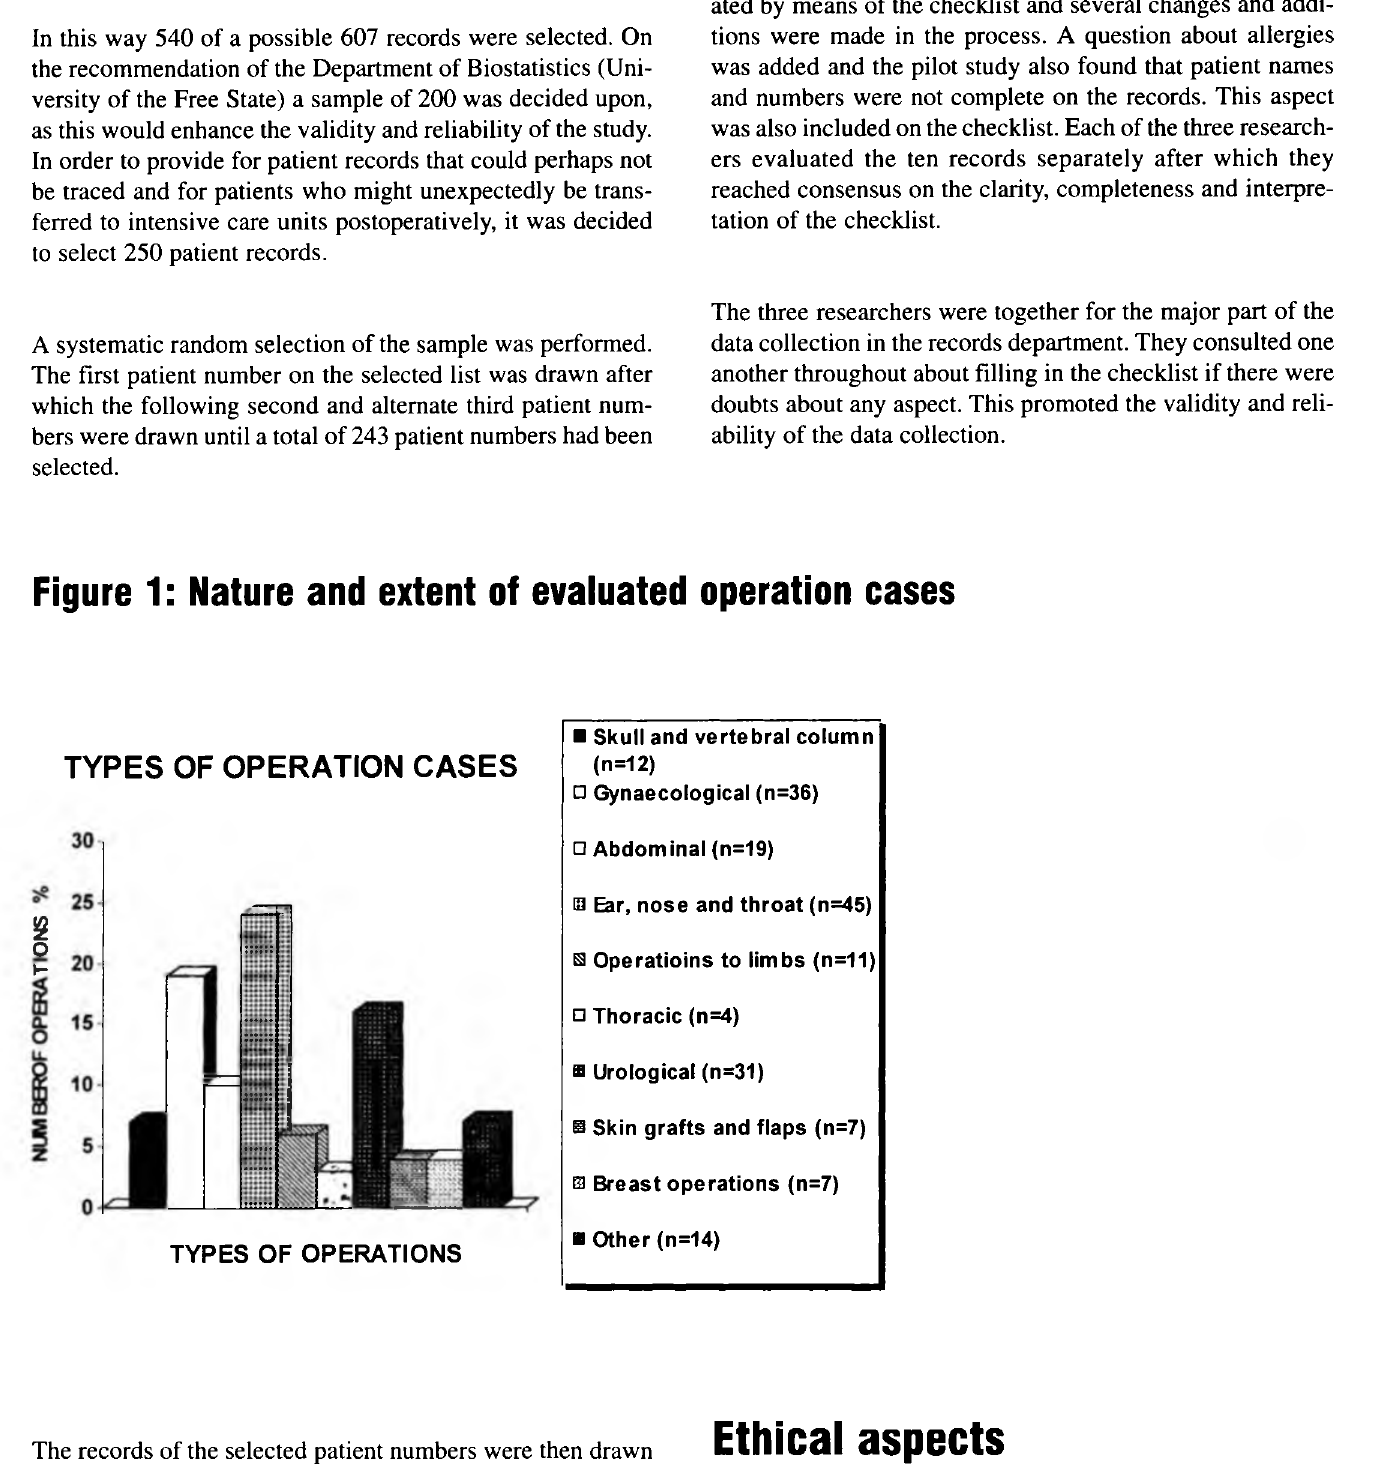
Figure 1 : Nature and extent of evaluated operation